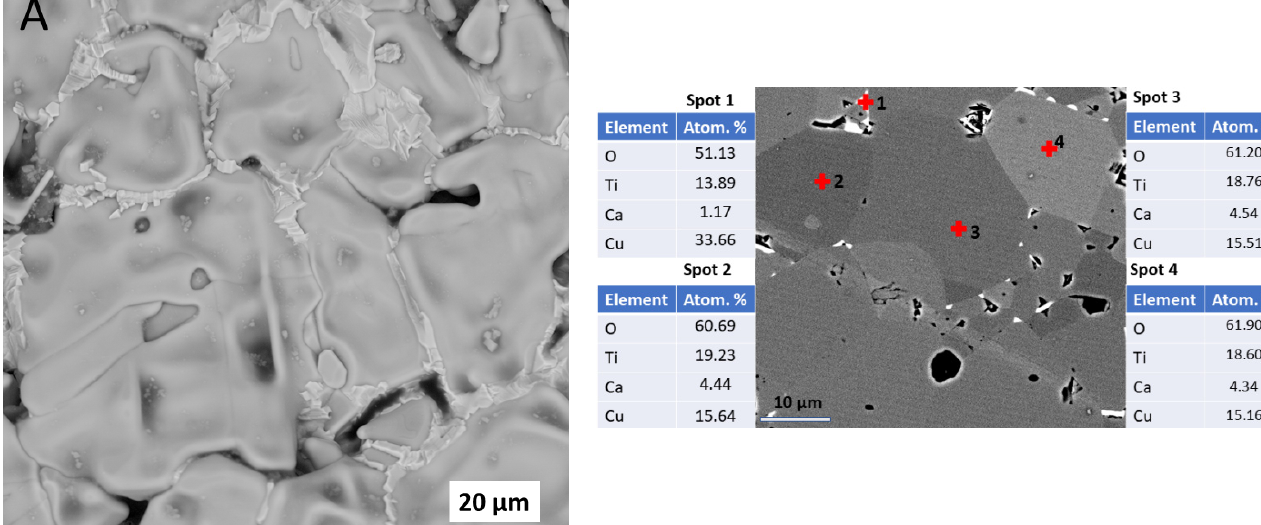
Figure 7. SEM-BSE micrographs of the sample I, HPF 1150 °C, 120 min ( A ) free surface; ( B ) polished section.